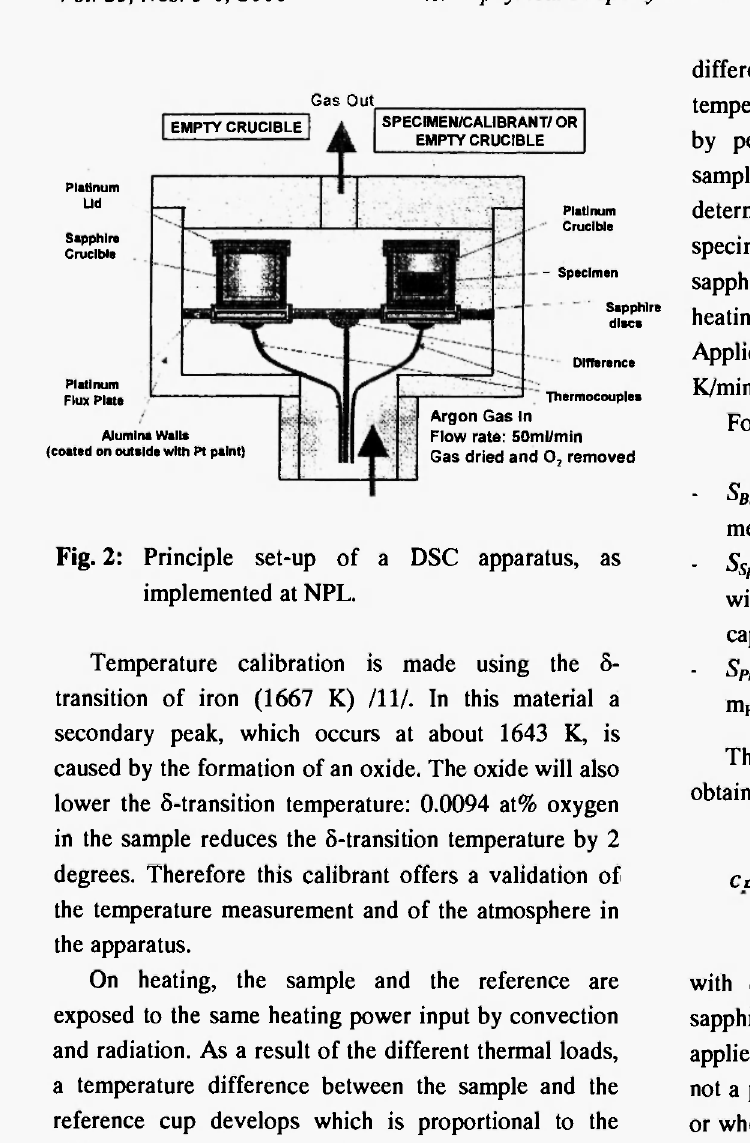
Principle set-up of a DSC apparatus, as implemented at